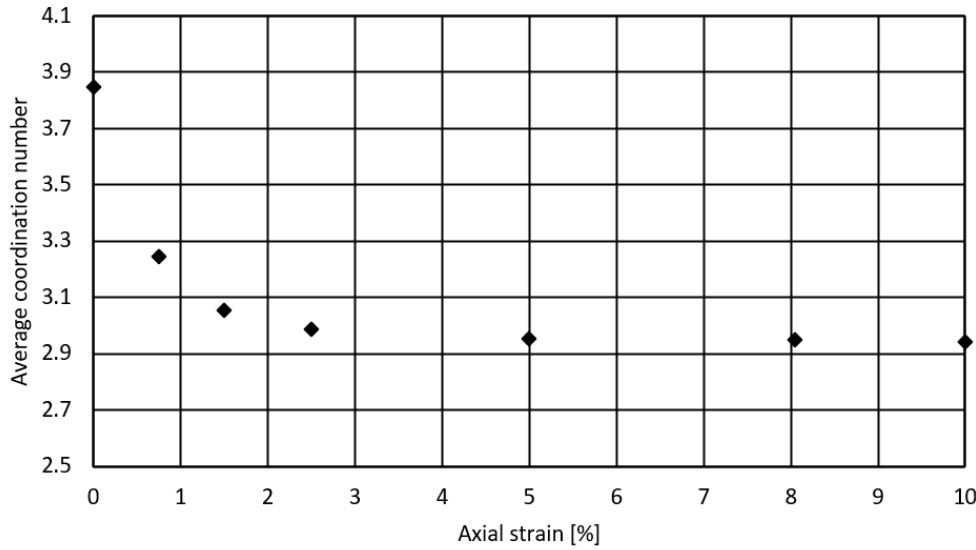
Figure 10. The variation of average coordination number with axial strain.